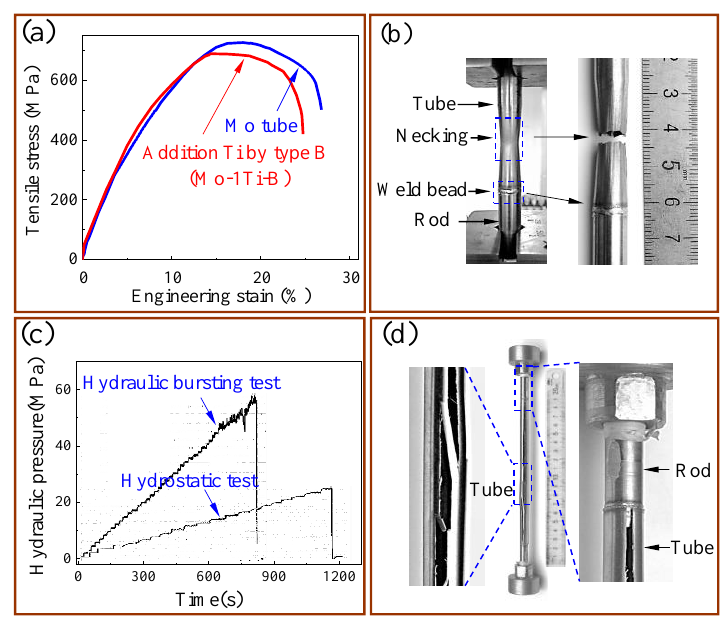
Figure 14. ( a ) Strength-displacement curves of Mo-0.03Ti-B and pure Mo tube; ( b ) images of the joint after fracture testing; ( c ) hydrostatic test curve and hydraulic bursting test curve for the molybdenum joint of Mo-0.03Ti-B; and ( d ) images of joint after hydraulic bursting testing [10].